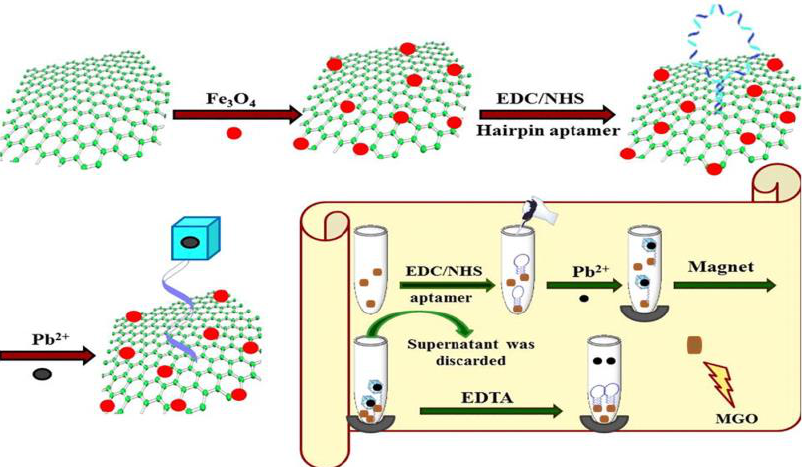
Figure 6. Scheme for synthesis of Fe 3 O 4 @GO nanocomposite with hairpin aptamer and the procedure for preconcentration of Pb(II) using this biosorbent [73].